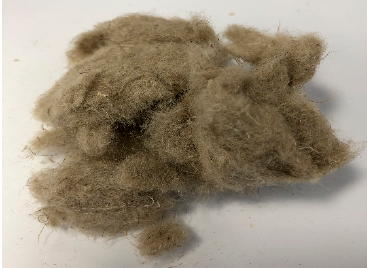
Figure 1. As-received yarn of short flaxseed fibers (FFs).